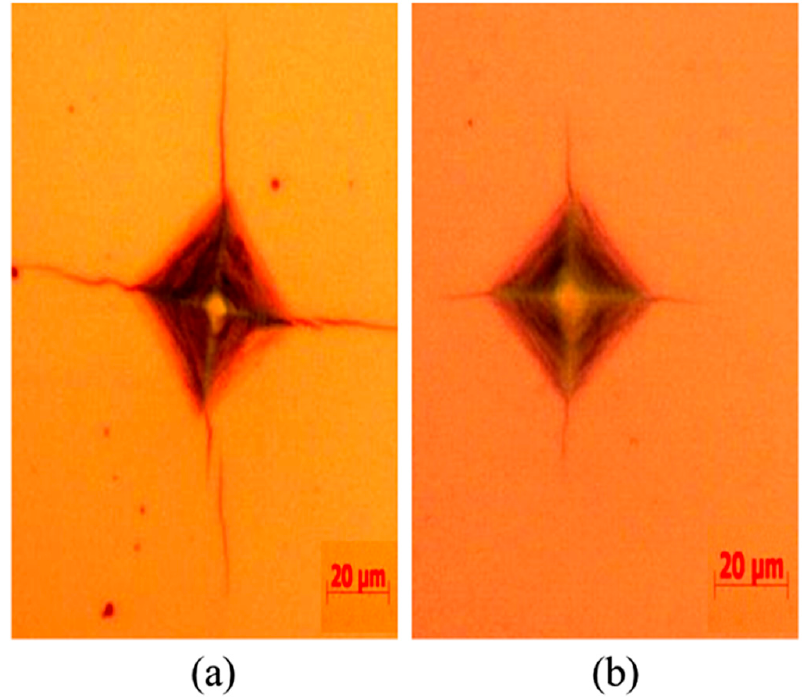
Figure 6. Typical microindentation morphology of ( a ) TiCuN-0Cu; and ( b ) TiCuN-16Cu.